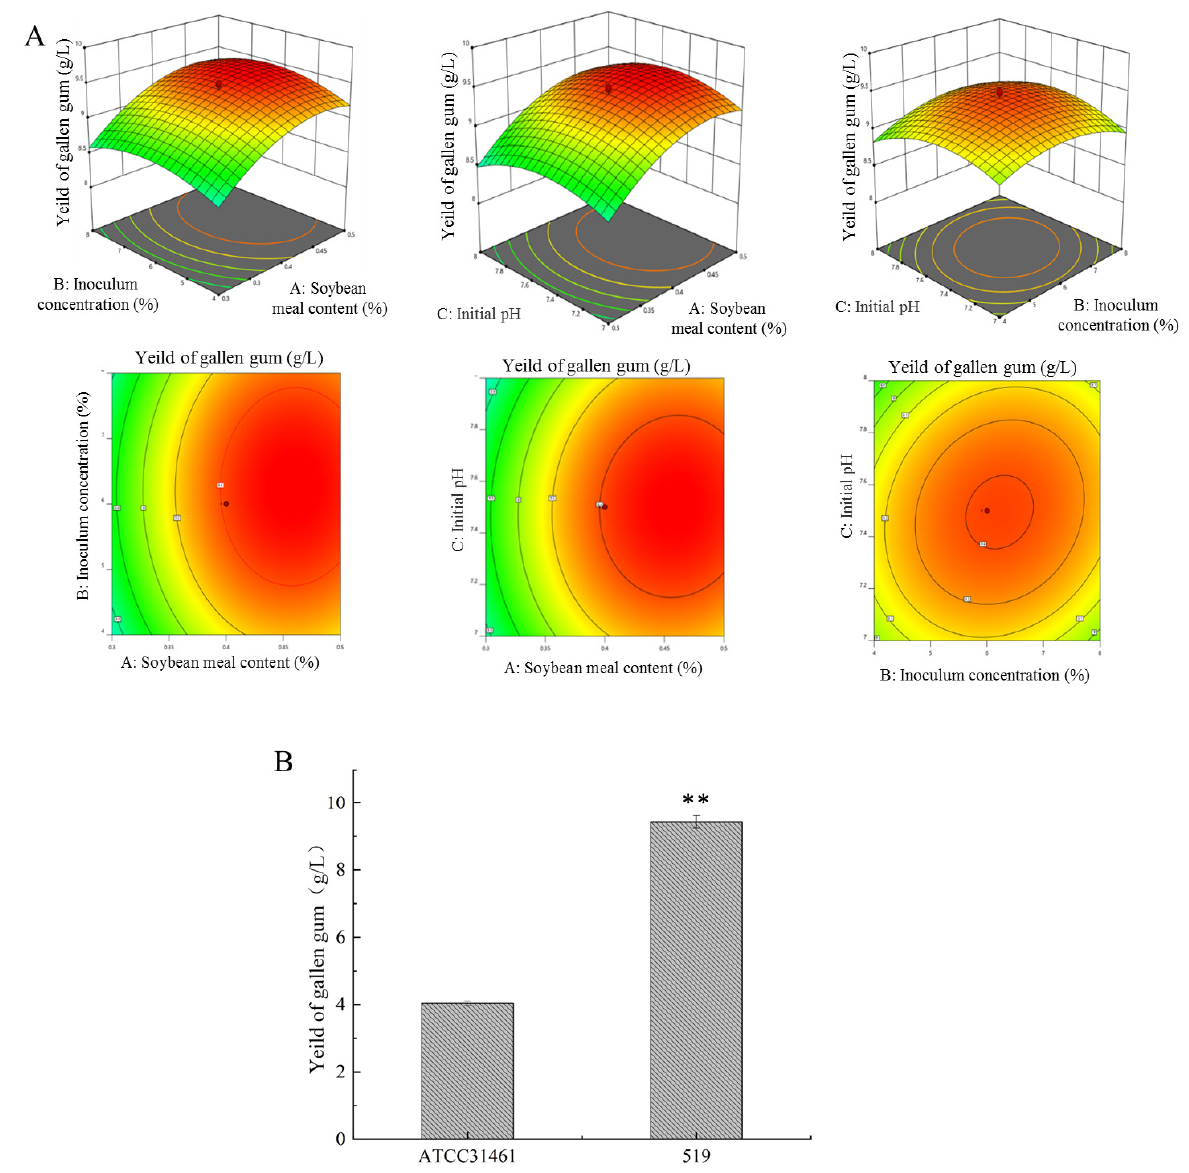
Figure 6. Optimization of fermentation conditions of mutant by Response Surface Methodology. ( A ) The effect of the interaction of fermentation conditions on the yield of gellan gum; ( B ) The experimental verification of the optimal fermentation conditions and yield. “**” represents a significant difference (p < 0.01). Table 4. Results of regression equation variance analysis.